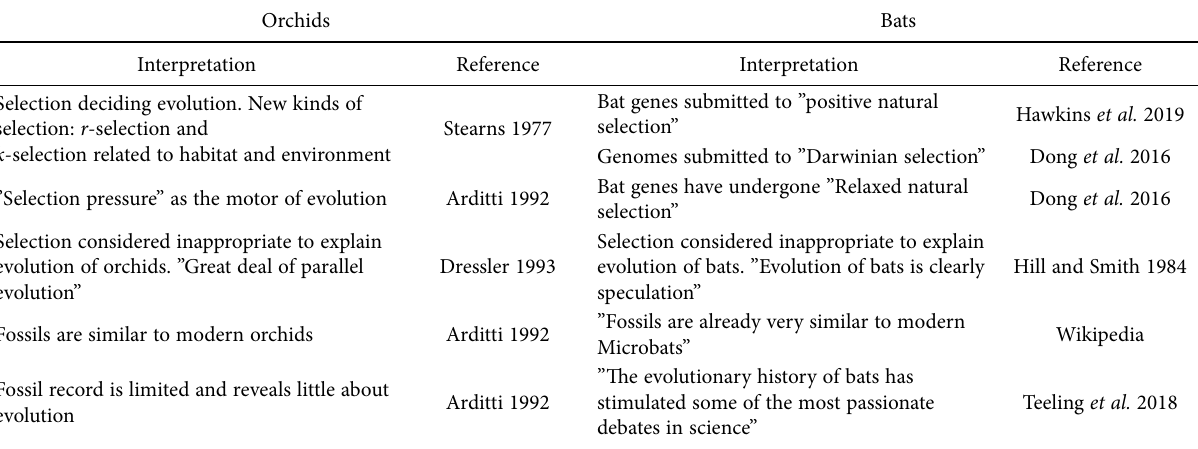
Table 7. Present interpretations of orchid and bat evolution, evoking selection as well as denying it. The statements made by the various authors are in quotation